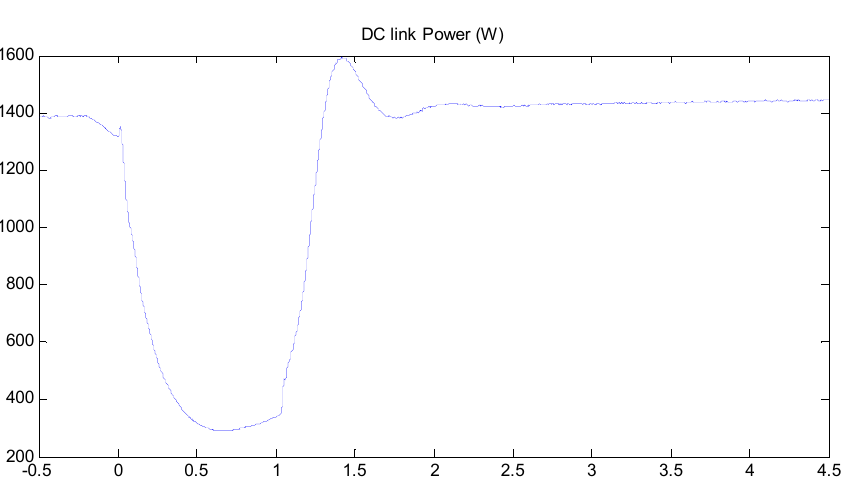
Figure 18. Power, (W) vs. time, (s) at the DC